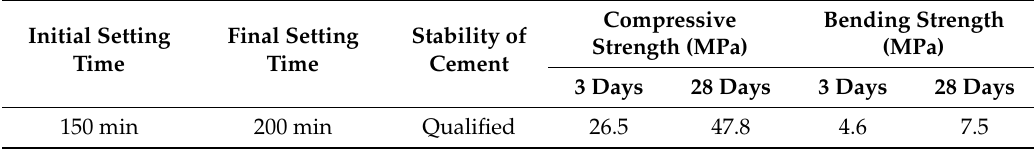
Table 1. Physical and mechanical properties of Portland cement.